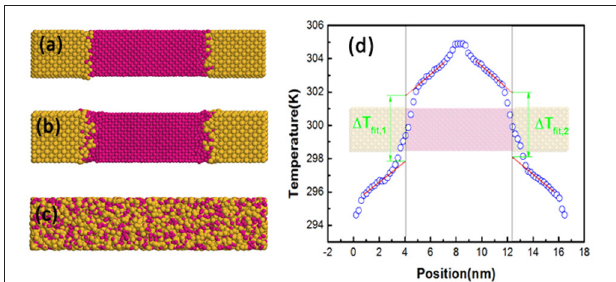
FIGURE 1 | (a–c) are the side views of simulation cell. The red atoms are Al, and the yellow atoms are Si. The lattice constants of Al and Si are 0.407